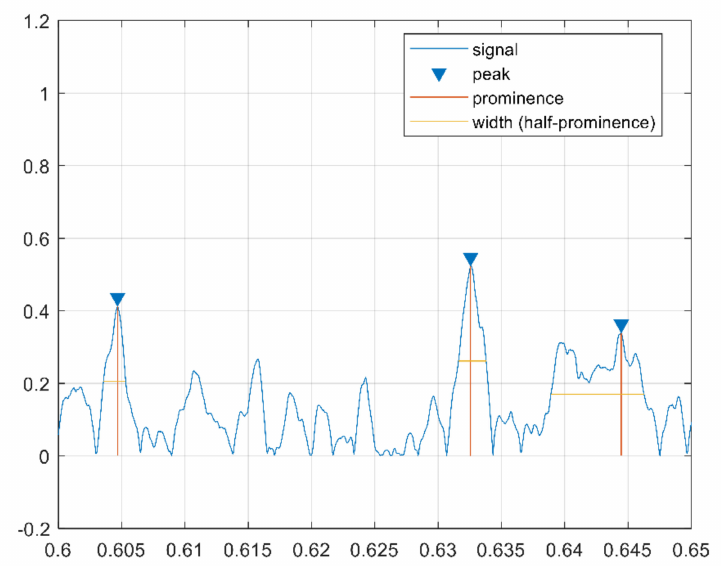
Figure 7. Cepstrum peak features for a noncorrugated sample.